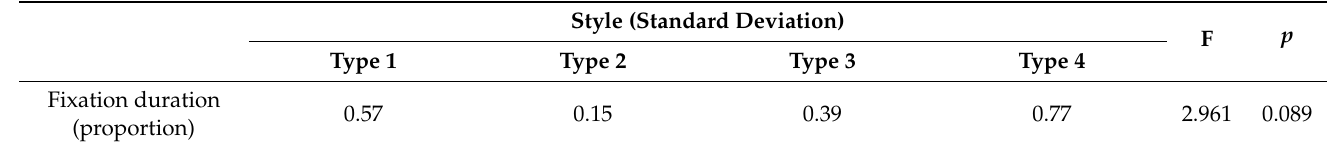
Table 11. Equal variance analysis of different styles of button fixation time.